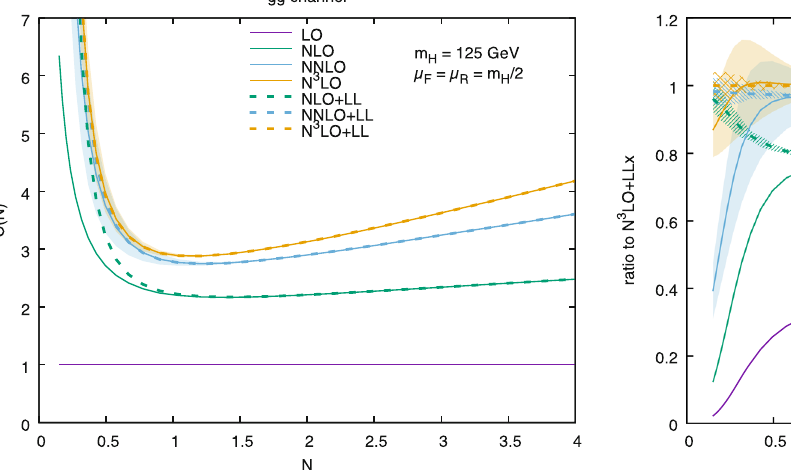
Fig. 4 Partonic gg -channel coefficient functions for ggH production in N space, at LO (solid purple), NLO (solid green), NNLO (solid blue) and N 3 LO (solid orange) and with resummation at NLO+LL (dashed green), NNLO+LL (dashed blue) and N 3 LO+LL (dashed orange). The left plots shows the actual coefficient functions, while the right plot shows their ratio to the highest-order result, N 3 LO+LL. Fixed-order results are supplemented with the uncertainty band obtained setting